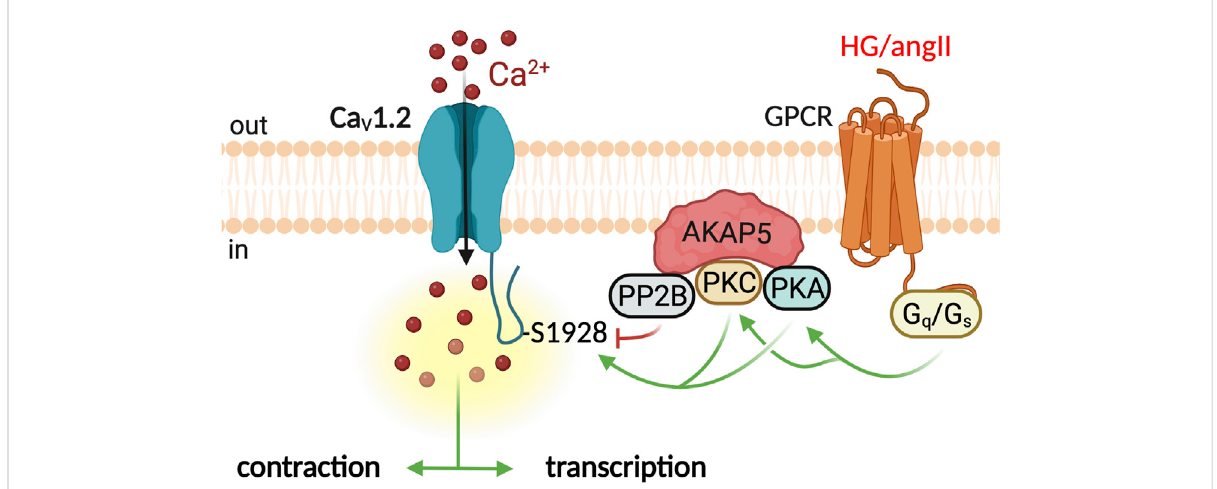
FIGURE 1 Ca V 1.2 molecular complex in the regulation of VSM contraction and transcription. Ca 2+ in fl ux through Ca V 1.2 channels is essential for the pressure-induced contraction of the VSM (Moosmang et al., 2003). Activation of G s /PKA signaling by high glucose or G q /PKC by angiotensin II potentiate Ca V 1.2 activity (Navedo et al., 2008; Navedo et al., 2010b; Prada et al., 2019). The scaffolding protein AKAP5 facilitates PKA/PKC phosphorylation of Ca V 1.2 channels at S1928 (Nystoriak et al., 2017a). The phosphatase PP2B opposes phosphorylation dampening Ca V 1.2 potentiation. Graphics created with